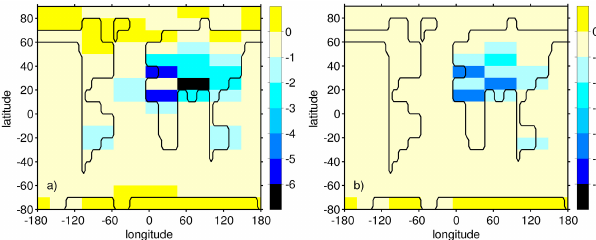
Figure 7. Geographic distributions of dust SW DRF at TOA (Wm − 2 ) with dust load of solution L1 and RI = 0 . 0015 for 21ka (a) and 0ka (b) .